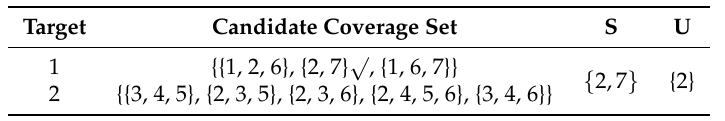
Figure 8. In the first selection, Target 1 is covered. Sensor 2 and Sensor 7 are activated. In the second selection. All targets have been covered by four sensors with the least detection probability threshold (cid:101) . Table 3. In the first selection, PSCA selects independent coverage set { 2,7 } . In the second selection, PSCA selects independent coverage set { 2,3,5 } . (a) First